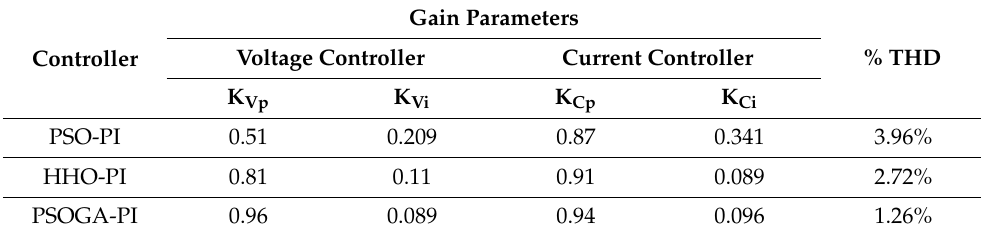
Figure 22. Leakage current in the grid-connected PV system. Table 6. Comparison of gain parameters and THDs of proposed GCSPV system.